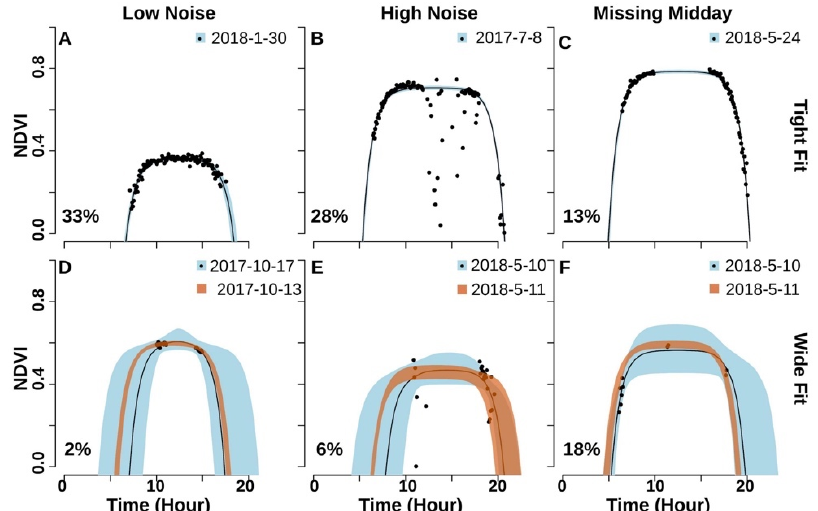
Figure 4. Example fits for six days of the year at different sites. The blue shading around the diurnal curve indicates the 95% credible interval for the black observation points. The black line indicates the mean fit for that day and the percentage given indicates the frequency of the category within the studied days. ( A ) The diurnal fit for 2018-01-30 at Hubbard Brook. ( B ) The diurnal fit for 2017-07-08 at Marcell. ( C ) The diurnal fit for 2018-05-24 at Morgan Monroe. ( D ) The diurnal fit for 2017-10-17 (blue shading and black points and line) and 2017-10-13 (orange shading) for comparison at Harvard Forest. ( E ) The diurnal fit for 2018-05-10 (blue shading and black points and line) and 2018-05-11 (orange shading) at Shining Rock. ( F ) The diurnal fit for 2018-05-10 (blue shading and black points and line) and 2018-05-11 at Shenandoah. The diurnal fit method produces estimates of the midday maximum NDVI value even when there is noise or < 5 observations within the midday window.